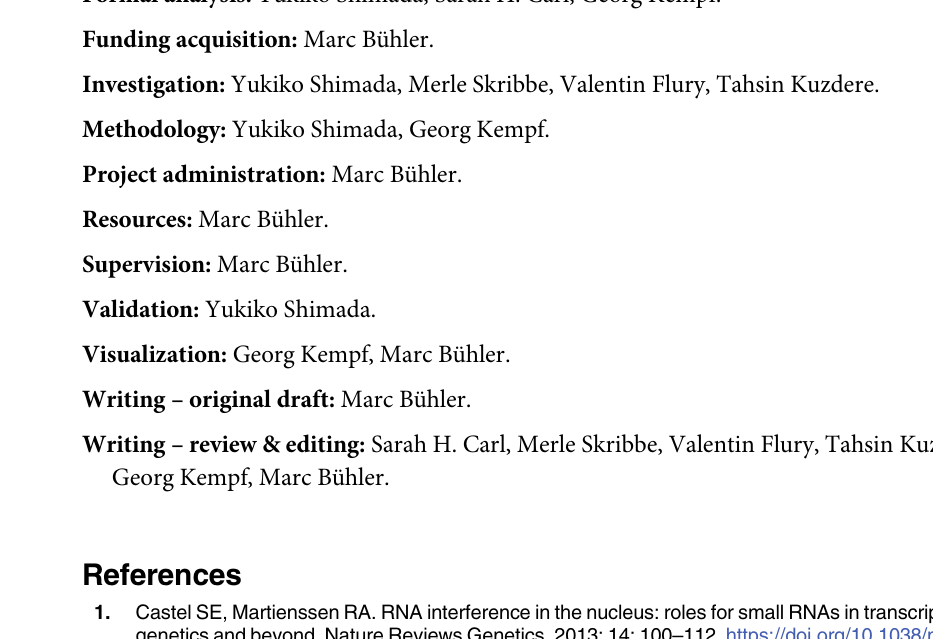
S3 Data. Values used to generate graph shown in Fig 2E. (XLSX) S4 Data. Values used to generate box plot shown in Fig 3E. (XLSX) S5 Data. Values used to generate box plot shown in Fig 3G. (XLSX) S6 Data. Values used to generate graphs shown in Fig 5C. (XLSX) S7 Data. Values used to generate box plots shown in S2 Fig. (XLSX) S8 Data. Values used to generate box plots shown in S4B and S4C Fig. (XLSX) S9 Data. Values used to generate graph shown in S5A Fig.